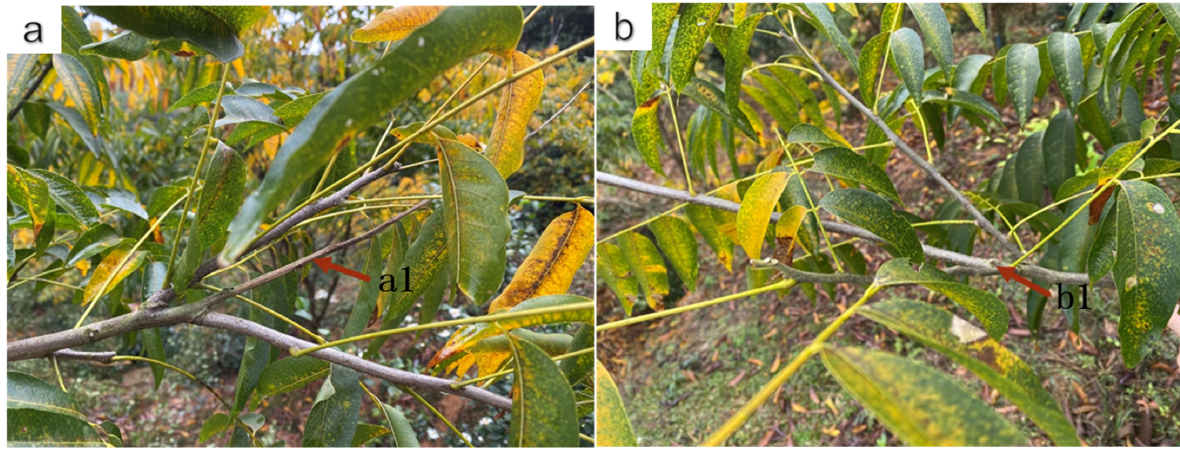
Figure 2. Types of Sapindus mukorossi parent shoots. ( a ) The parent shoots that developed from bearing shoots (type F), ( a1 ) persistent infructescence of bearing shoot of previous year; ( b ) the parent shoots that developed from vegetative shoots (type V), ( b1 ) top of vegetative shoot of previous year.